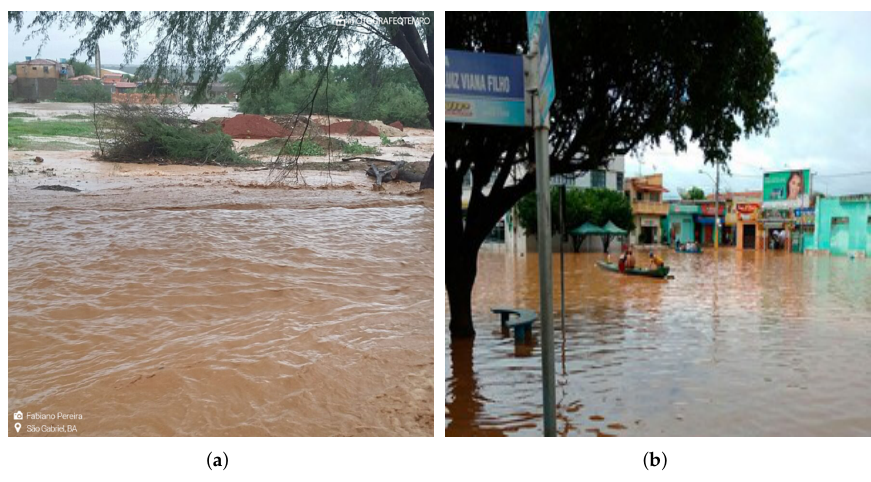
Figure 11. Municipalities affected by the extreme rain. ( a ) flooding in municipality of São Gabriel in Bahia state; ( b ) flooding in municipality of Santa Maria da Vitoria in Bahia state. Photographs: Fabiano Pereira/Fotografe o tempo and